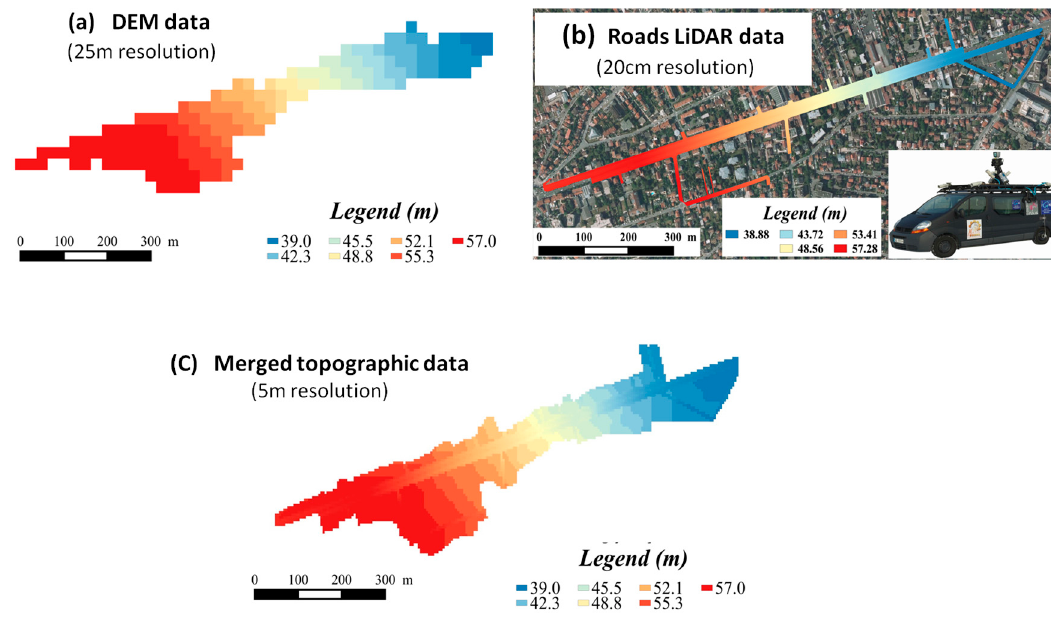
Figure 4. Topographic input data. ( a ) DEM data of 25 m resolution; ( b ) Roads LiDAR data of 20 cm resolution; ( c ) Merged topographic input data of 5 m resolution.